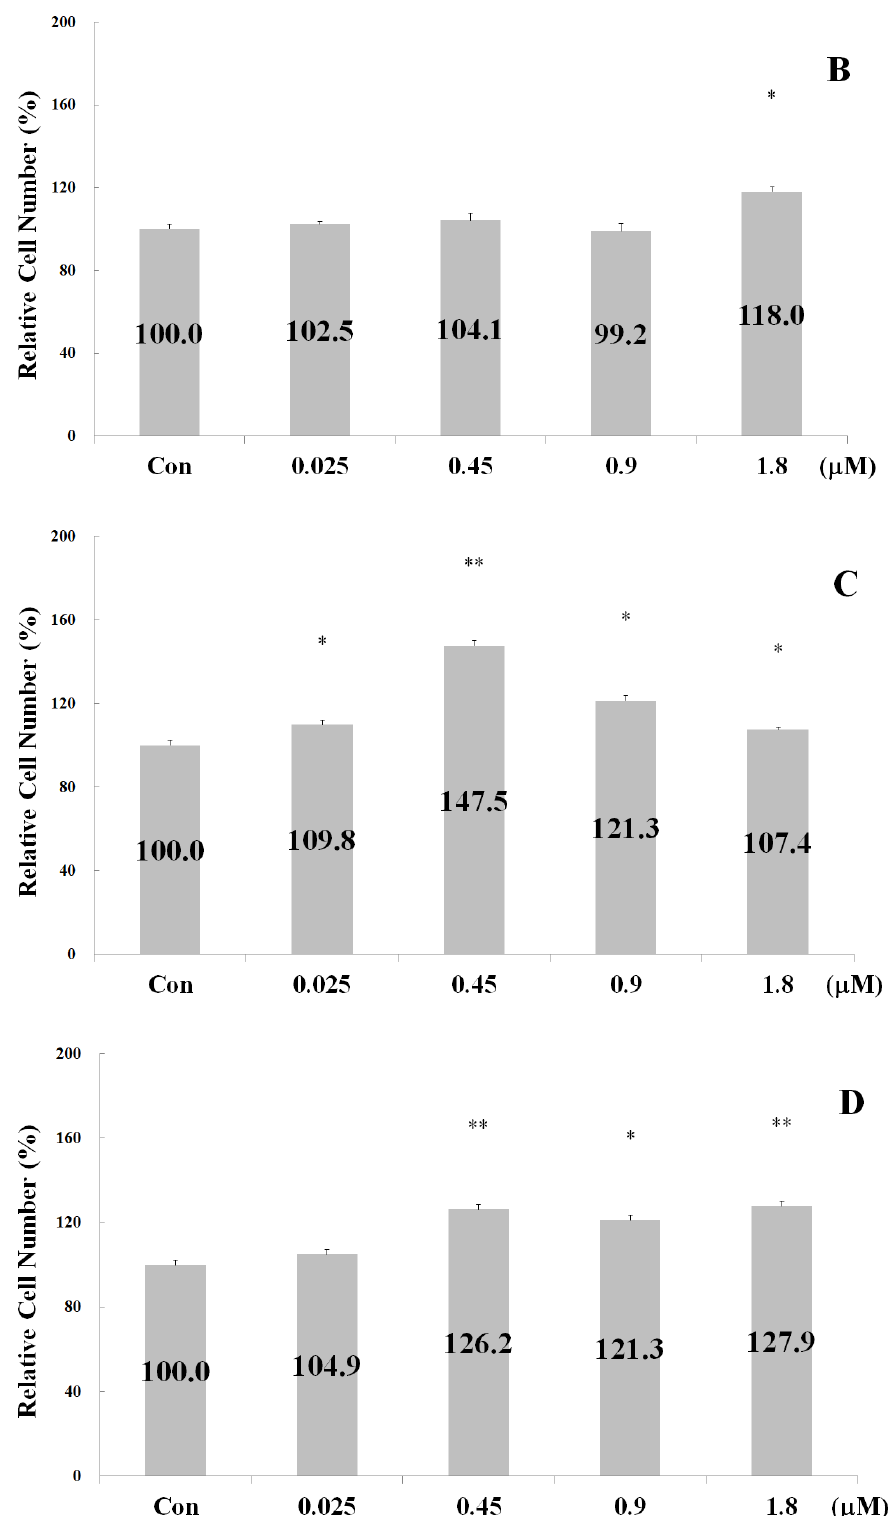
Figure 4. Effects of the synthetic peptides on chondrocyte proliferation after treatment for 24 h. ( A ) Peptide 5; ( B ) Peptide 4; ( C ) Peptide 3; ( D ) Peptide 2. Note: Chondrocyte proliferation activity was represented as the cell number. Data are presented as means ± SD in three independent experiments. The differences between the various peptide concentration treatment and the control groups ( A – D ) were analyzed using a one - tailed test , * p < 0.05 and ** p < 0.005.